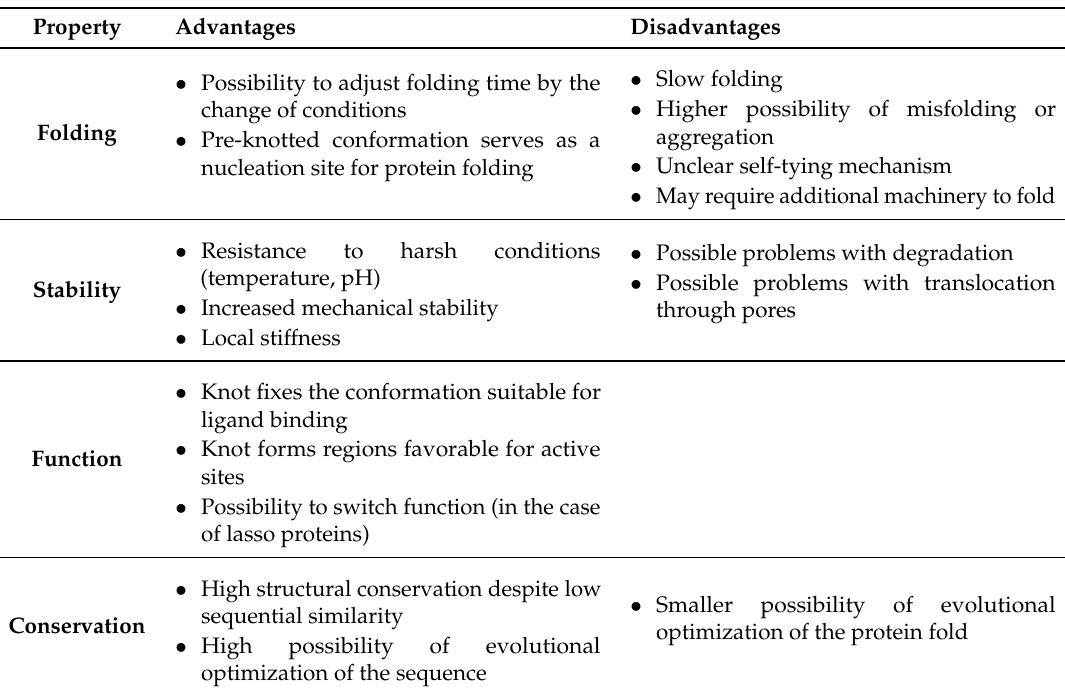
Table 1. Advantages and disadvantages of the complex topology in